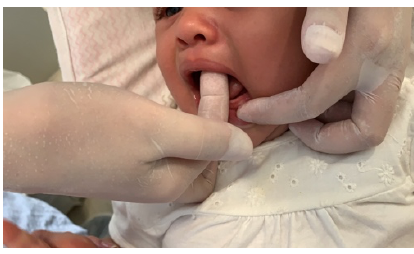
Figure 5. Intervention where the index finger is placed under the palatine papilla with slight pressure (up to a small ischemia) [10].